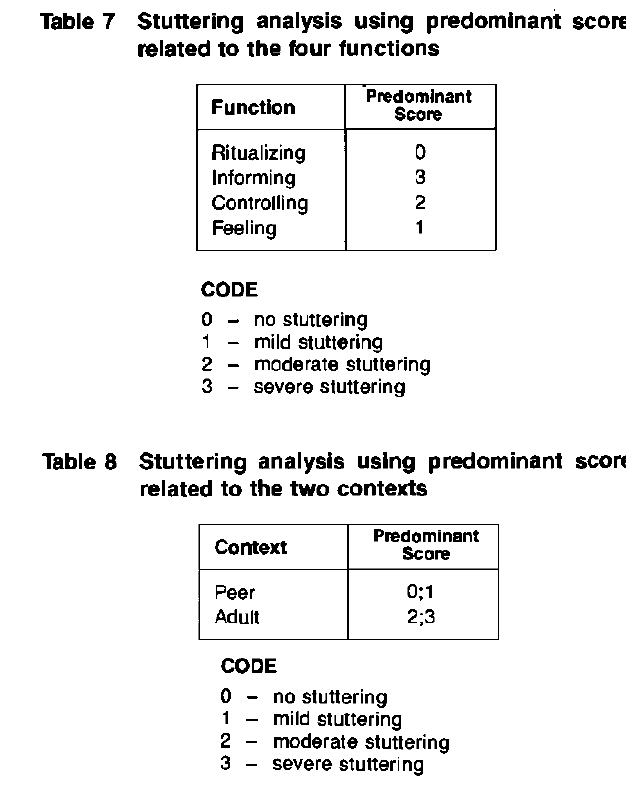
Table 6 Summary of the mean percentage and predominant scores for Ss' communicative com-